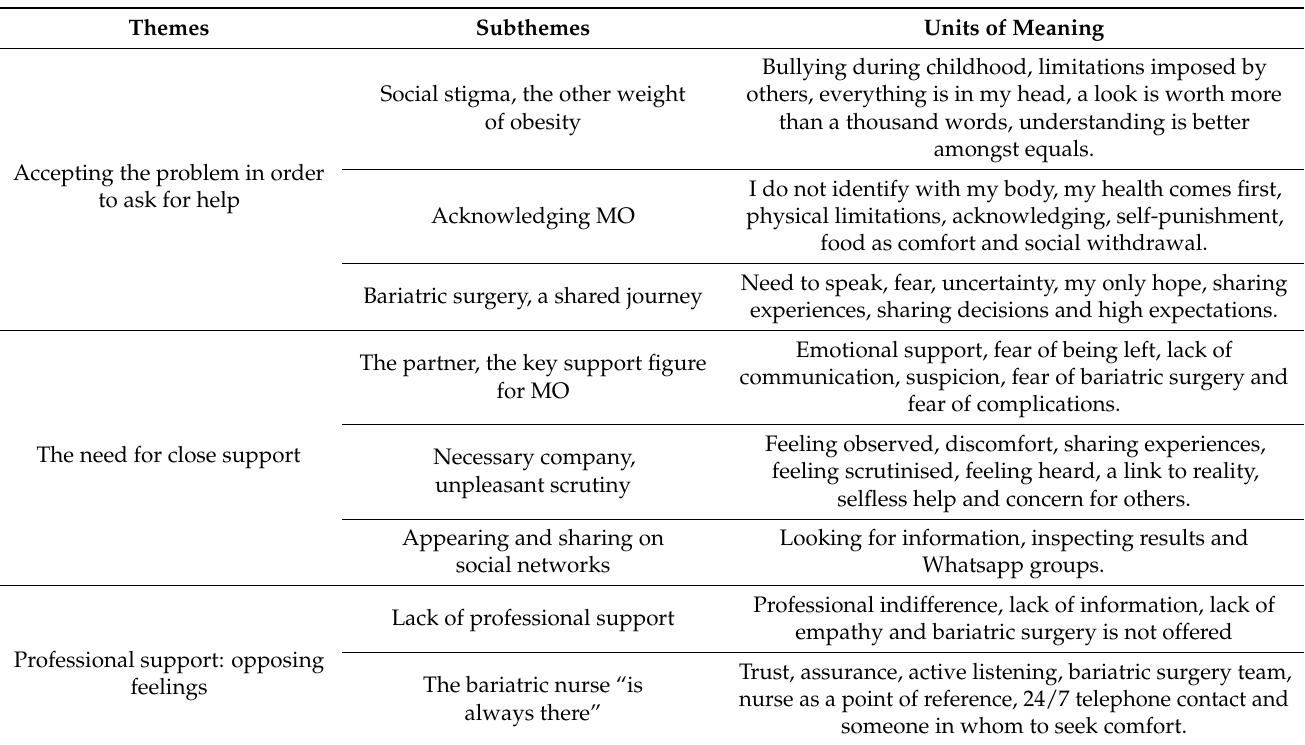
(Table 1). Three themes allowed for the description and understanding of the social support experienced by patients with MO in a bariatric surgery programme (Table 3). Table 3. Themes, subthemes and units of